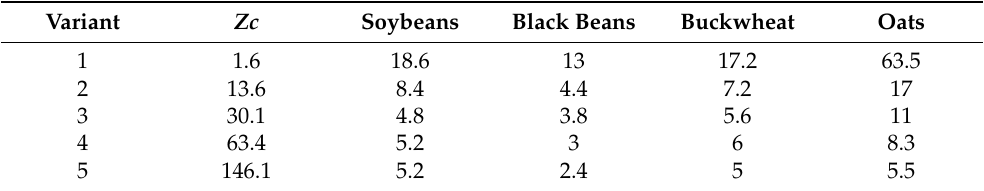
Table 6. The biological absorption coefficients of cadmium for all crops and the total pollution index.